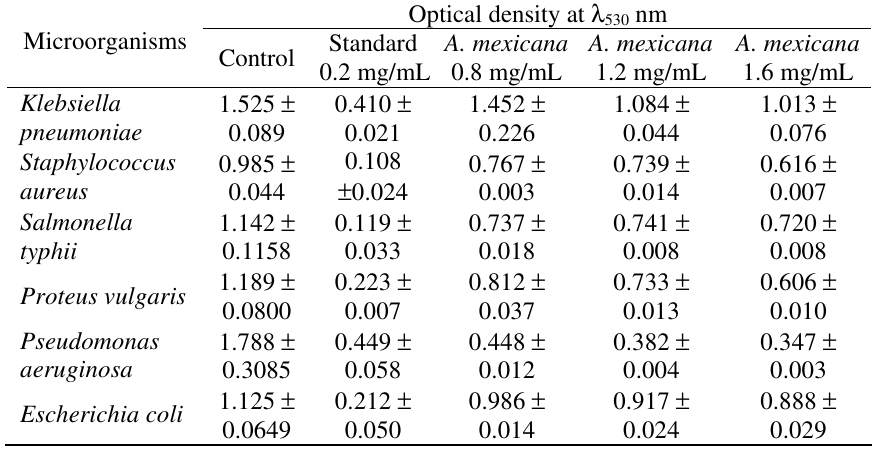
Table 2. Evaluation of the antimicrobial bioassay of ethanolic extract of Argemone mexicana L